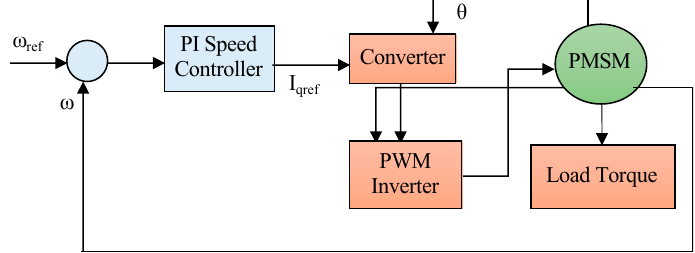
Figure 2. Basic structure of PMSM PI controller.